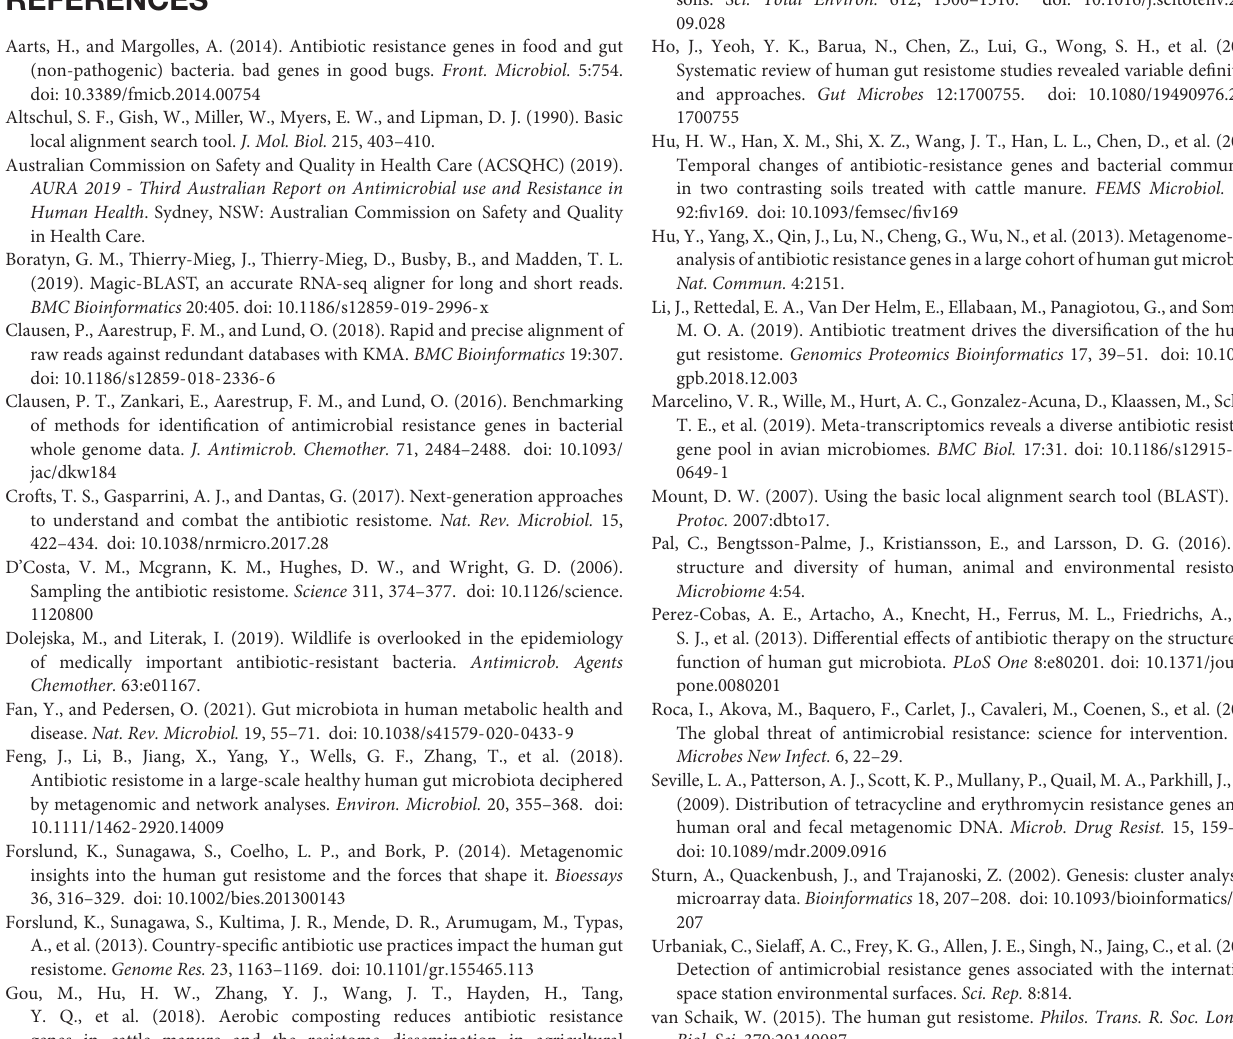
method. Contigs were queried against the NCBI’s AMR reference gene database using either of the two methods. The outputs from ResFinder are provided as available online; column “Alignment length/ref length” originating from the SMS + BLAST method is provided for comparison. For antimicrobial resistance genes detected only by one out of the two methods, the result shows as N/A (not available). § Gene absent from the ResFinder database; ∗ abundance (calculated “mean base depth per 5 million reads” with the shotgun metagenomic sequencing + BLAST analysis) ≤ 1. Blue rows indicate resistance genes identified with the SMS + BLAST method only (i.e., not detected with ResFinder). Supplementary Table 5 | Results from the SMS + BLAST method and a targeted metagenomic sequencing method using the Ion AmpliSeq TM AMR Research panel (Life Technologies). Results obtained with the AMR panel were analyzed with the One Codex online platform (available at: https://app.onecodex.com/); depth is defined as the average number of reads piled up across the entire gene. SMS, shotgun metagenomics sequencing; BD5M, mean base depth per 5 million reads; MLS, macrolide, lincosamide, streptogramin B; QAC, quaternary ammonium compounds; gni, gene not included in Bioproject database; gnp, gene not included in the AMR panel. Genes detected with both methods are highlighted in green; genes in blue are detected with the AMR